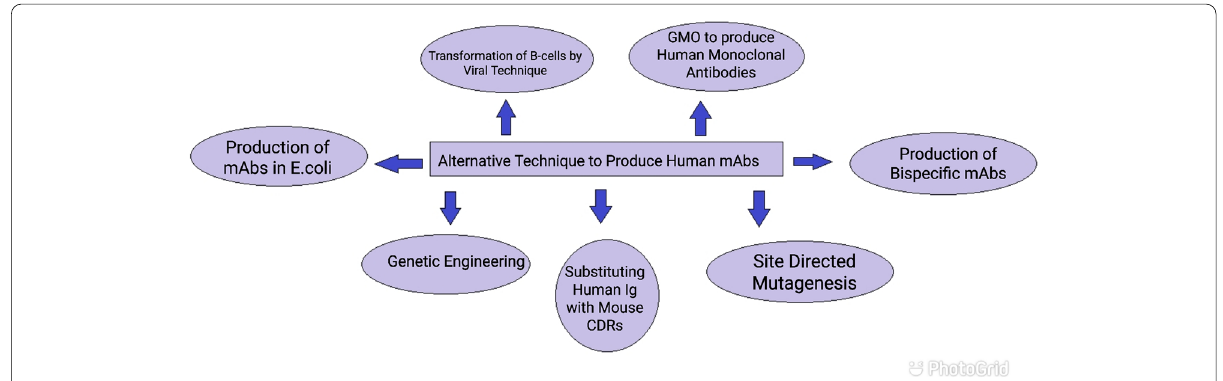
Fig. 7 Techniques to produce human monoclonal